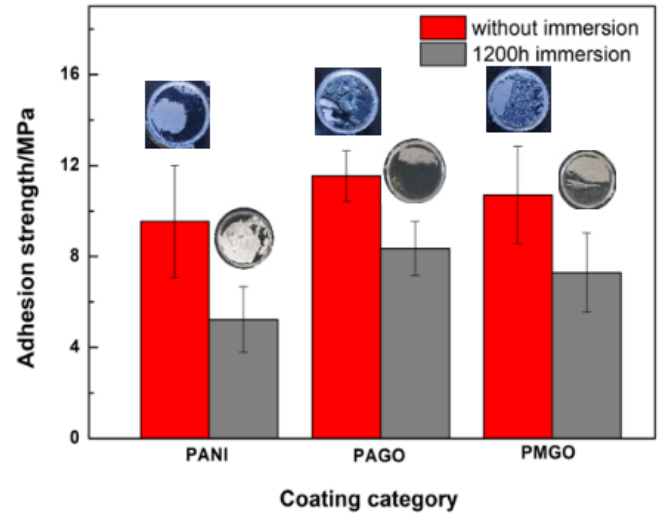
Figure 5. Dry and wet adhesions of the three kinds of coatings .